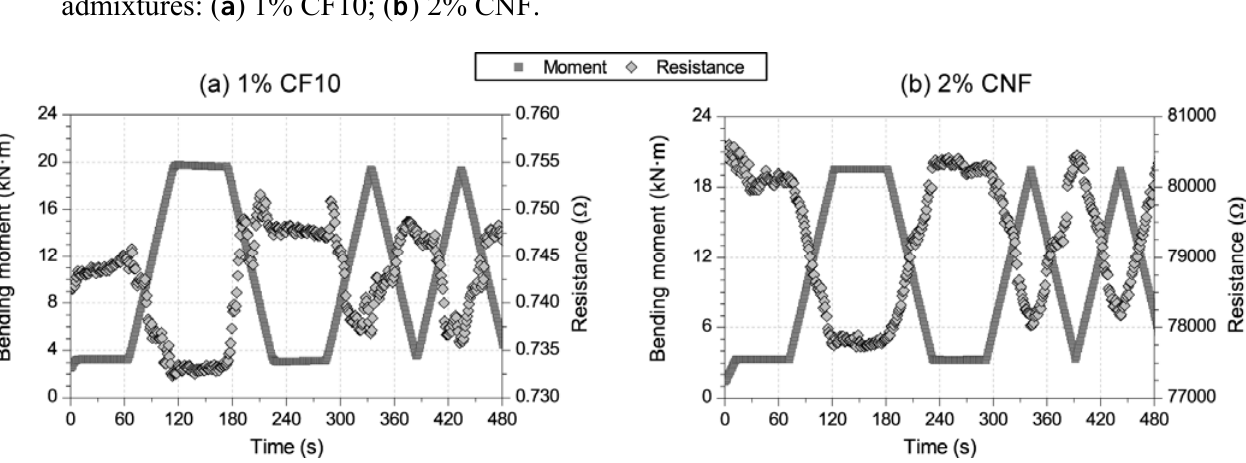
Figure 4. Electrical resistance and bending moment in the middle cross section versus time for sensors located on the compression side of the RC beam and with different conductive admixtures: ( a ) 1% CF10; ( b ) 2% CNF.